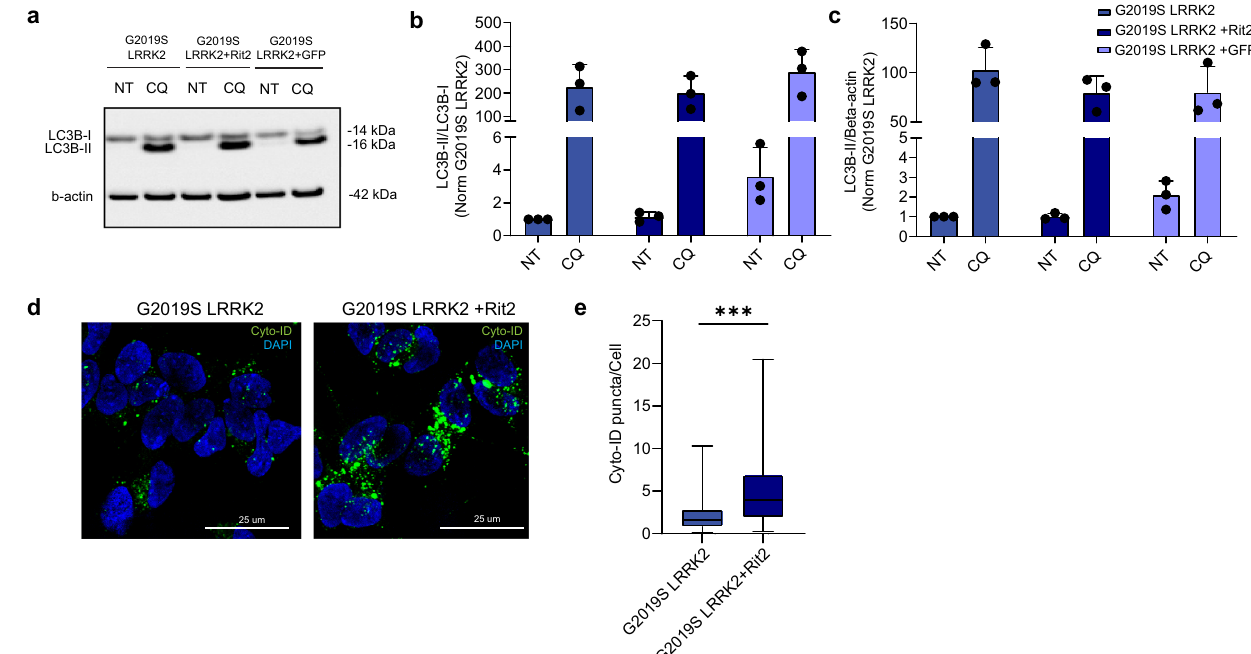
Fig. 2 Overexpression of Rit2 does not affect overall autophagic fl ux. a The autophagic fl ux was assessed in G2019S-LRRK2, G2019S- LRRK2 + Rit2 and G2019S-LRRK2 + GFP cells upon treatment with CQ (100 µM, 3 h) and WB for LC3B. b The ratio between LC3B-II and LC3B-I was not different, suggesting no differences in autophagic fl ux ( n = 3). c Quanti fi cation of LC3B levels (normalized to β -actin) indicated no differences upon Rit2 overexpression or CQ-treatment ( n = 3). d CytoID assay was employed to visualize autophagosome and autolysosome distribution. e Quanti fi cation of CytoID-positive puncta revealed a signi fi cant increase in G2019S-LRRK2 cells, when Rit2 was overexpressed ( n = 4). Data are represented as median, boxes show the IQ and whiskers show min – max or means ± SEM. In imaging experiments, analysis was conducted on 700 – 1000 cells per group in each experiment. *** p < 0.01, unpaired two-tailed Student ’ s t